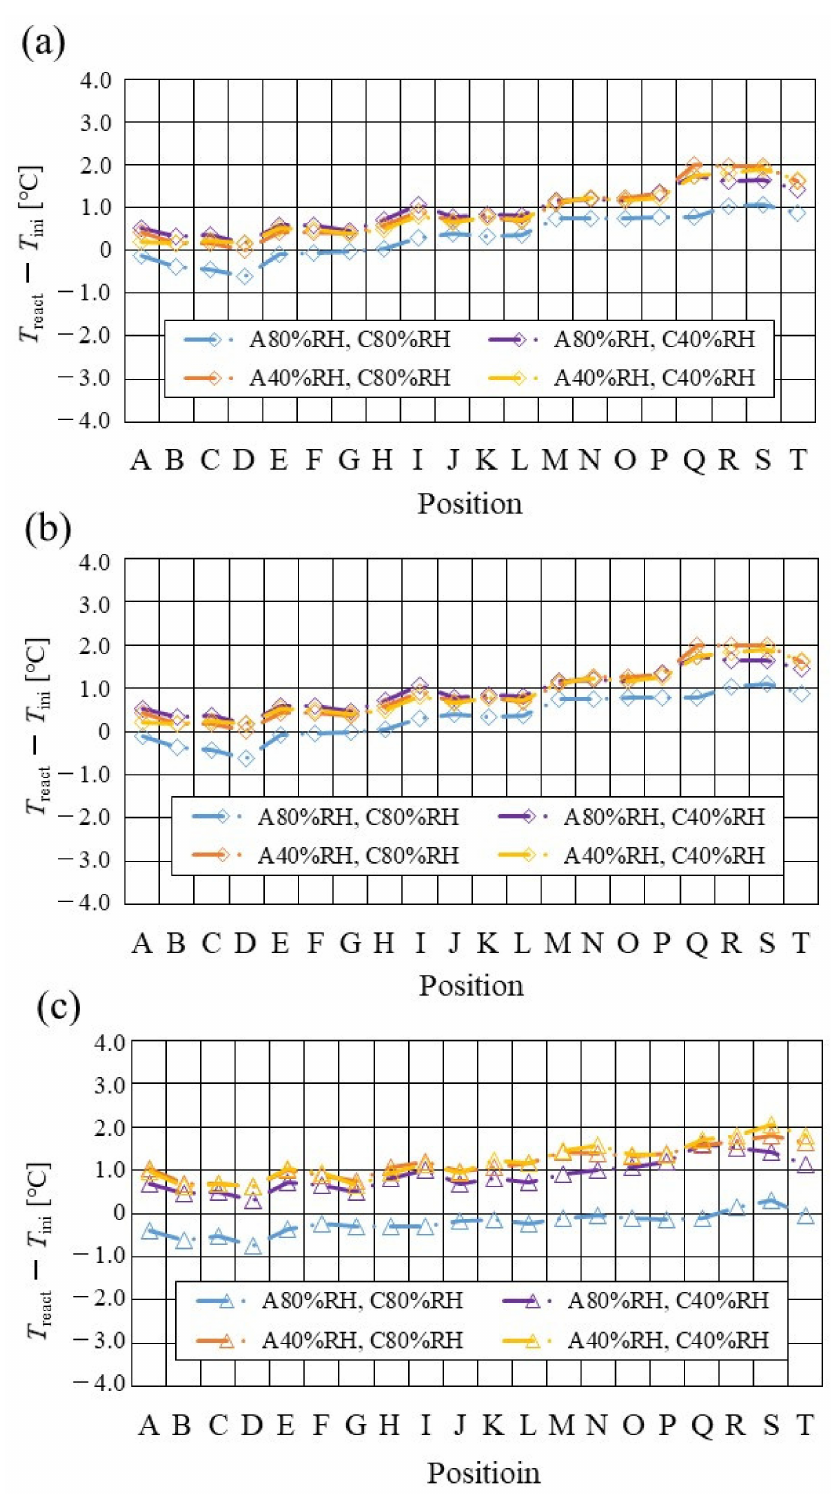
Figure 9. Comparison of distribution of temperature difference, between temperature at reaction sur- face and initial operation temperature, among different relative humidity conditions and initial oper- ation temperature for the separator thickness of 1.0 mm: ( a ) the initial operation temperature = 80 ◦ C, ( b ) the initial operation temperature = 90 ◦ C, ( c ) the initial operation temperature = 100 ◦